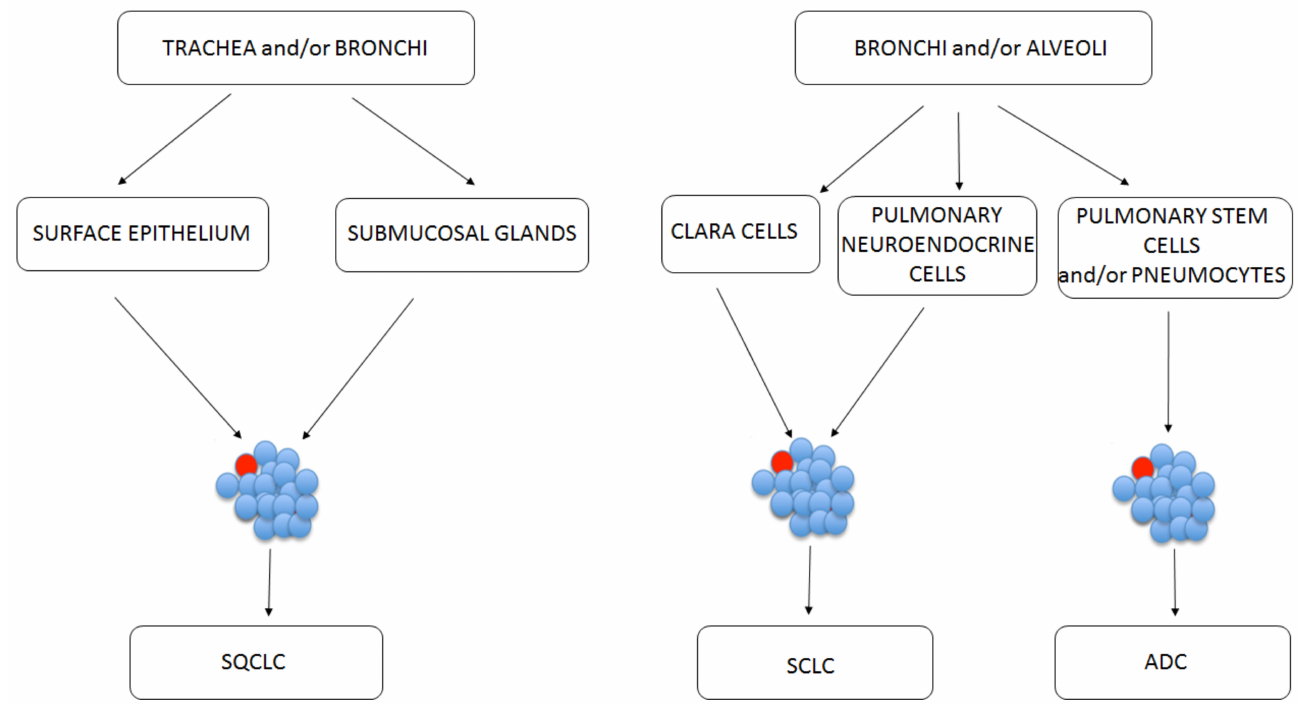
Figure 2. Possible CSC (marked red) initiation sites depending on the lung cancer